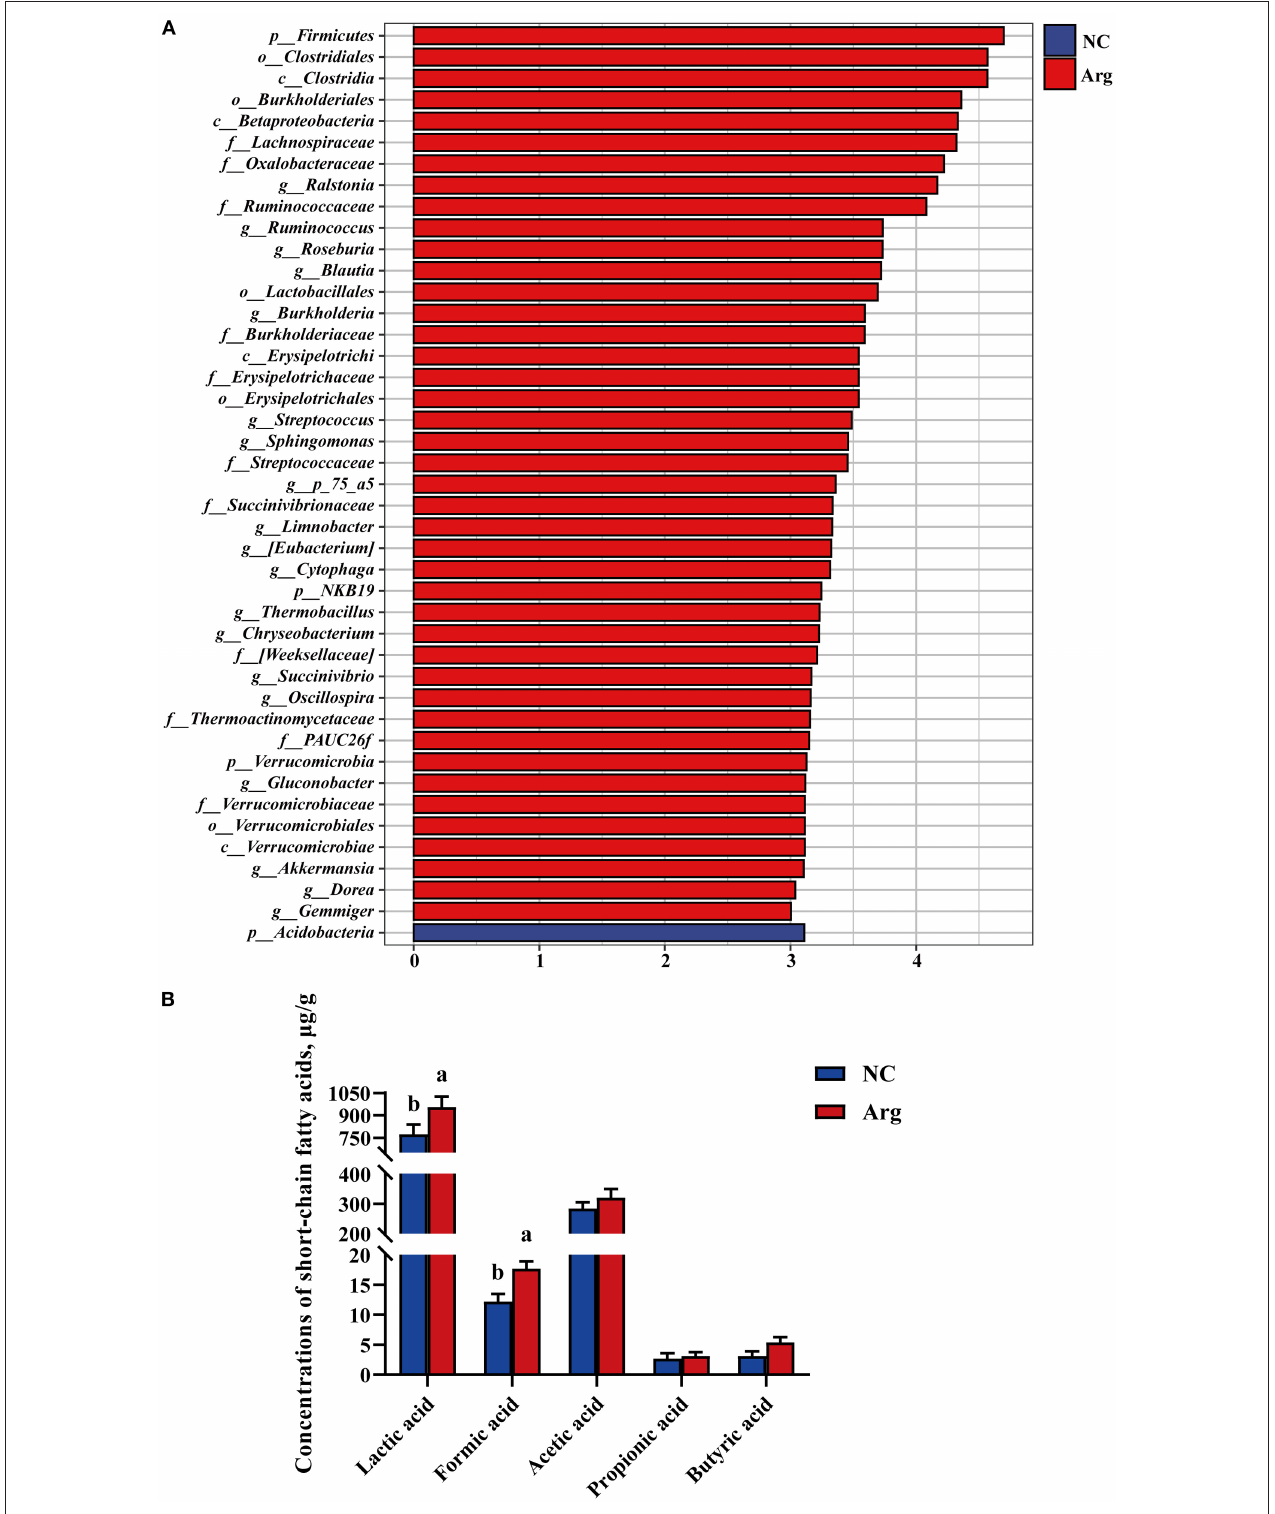
FIGURE 5 | Linear discriminant analysis effect size and effects of in ovo feeding of L -arginine on concentrations of cecal short-chain fatty acids at the age of embryos 21. (A) Species with significant difference that have an LDA score greater than the estimated value 3. And the length of the histogram represents the LDA score; (B) Concentrations of cecal short-chain fatty acids. a,b Values at the same index with no common superscripts differ significantly ( p < 0.05); NC, non-injected control group; Arg, injected with 7mg L -arginine group.